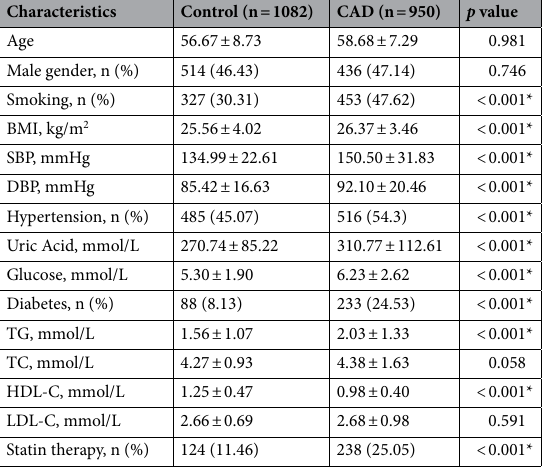
Table 1. Baseline characteristics of control subjects and patients with coronary heart disease. BMI body mass index, SBP systolic blood pressure, DBP diastolic blood pressure, TC total cholesterol, TG triglyceride, LDL- C low density lipoprotein-cholesterol, HDL-C high density lipoprotein-cholesterol. *Compared with control group, p -values <